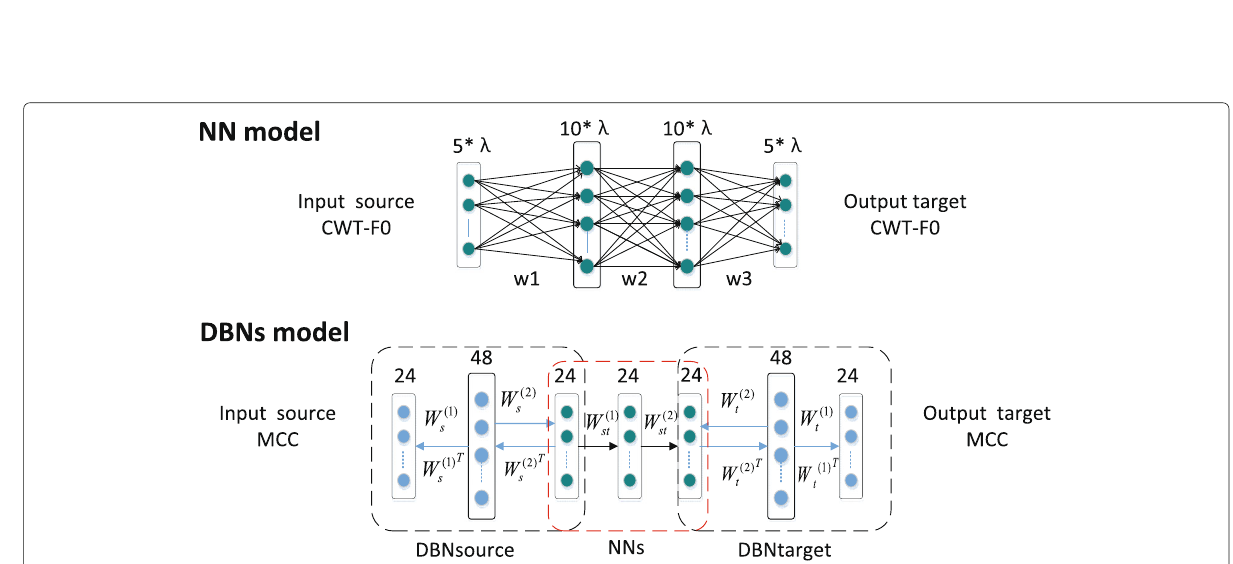
Fig. 5 Training model of the proposed